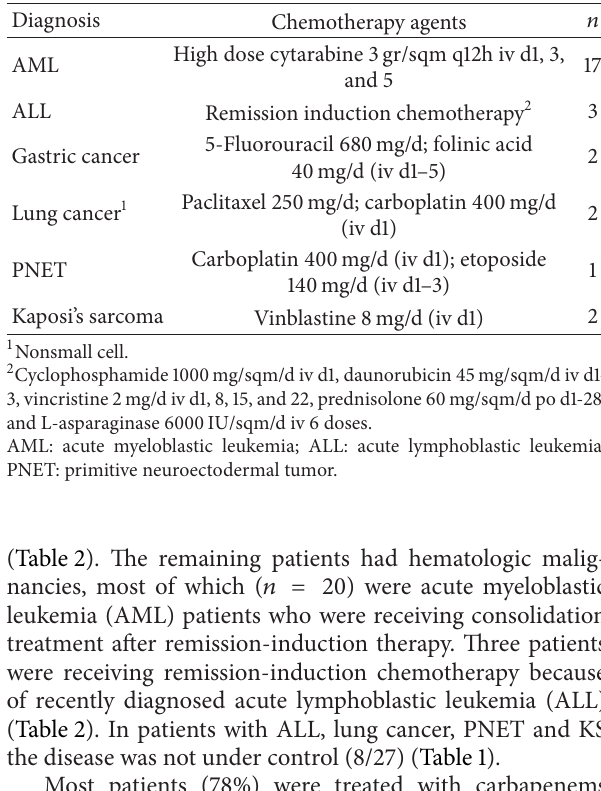
Table 2: According to diagnosis used chemotherapy